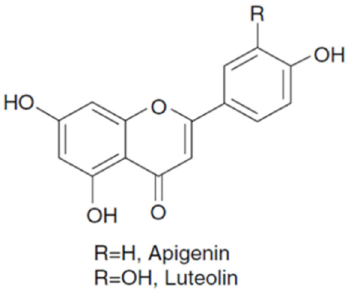
Figure 3. Structures of the major flavones.